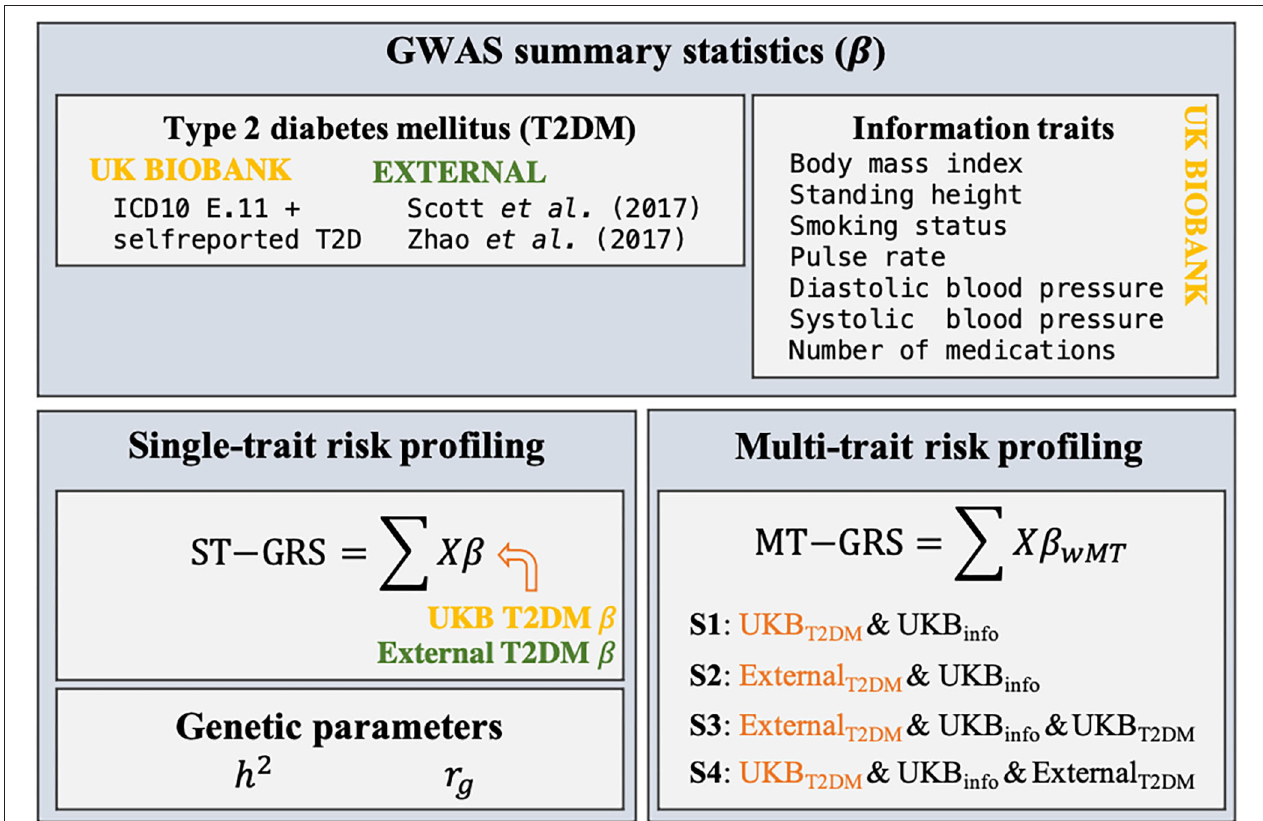
FIGURE 1 | Schematic overview of the research design of the current study. Summary statistics ( β ) for T2DM and seven information traits were estimated from individual-level genotypic information ( X ) within the UKB using a 10-fold cross validation scheme. Two external GWAS summary statistics were identified. ST-GRS for T2DM was computed based on either the summary statistics obtained within the UKB or from the two external data sets. Estimates of the heritability ( h 2 ) and genetic correlations ( r g ) were estimated for T2DM, the seven information traits, and the two external T2DM studies. MT-GRS were computed based on four scenarios (S1–S4), depending on which types of information the predictor variable was adjusted